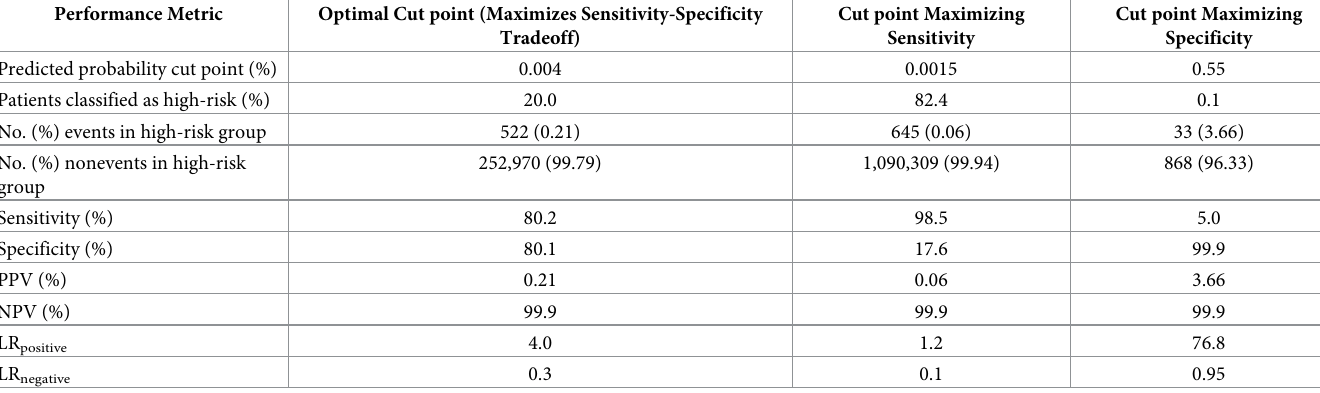
Table 4. Performance of elastic net model predictions for classifying patients into high-risk and low-risk